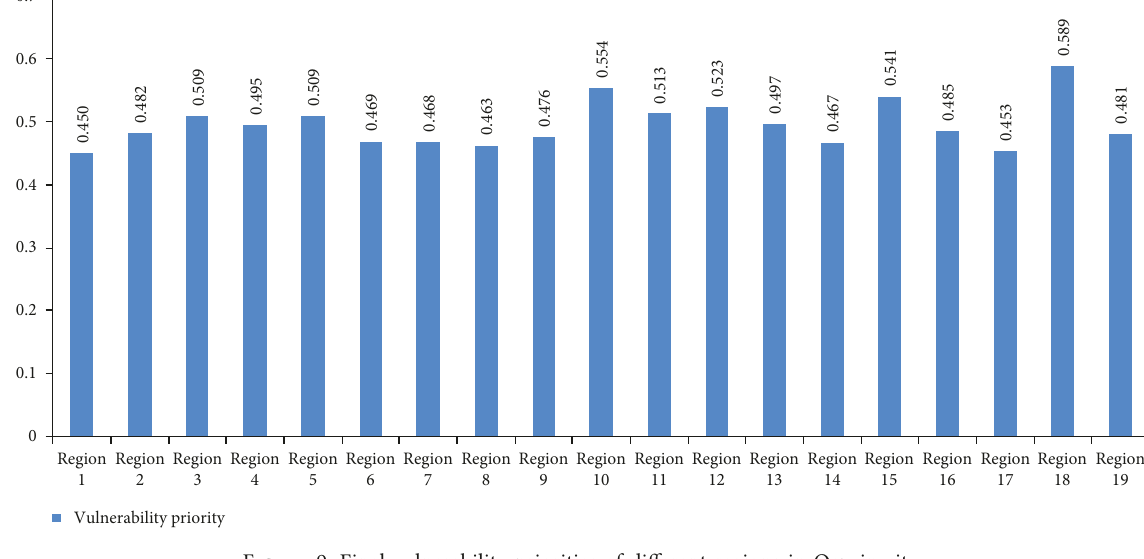
Figure 9: Final vulnerability priorities of different regions in Qazvin city.